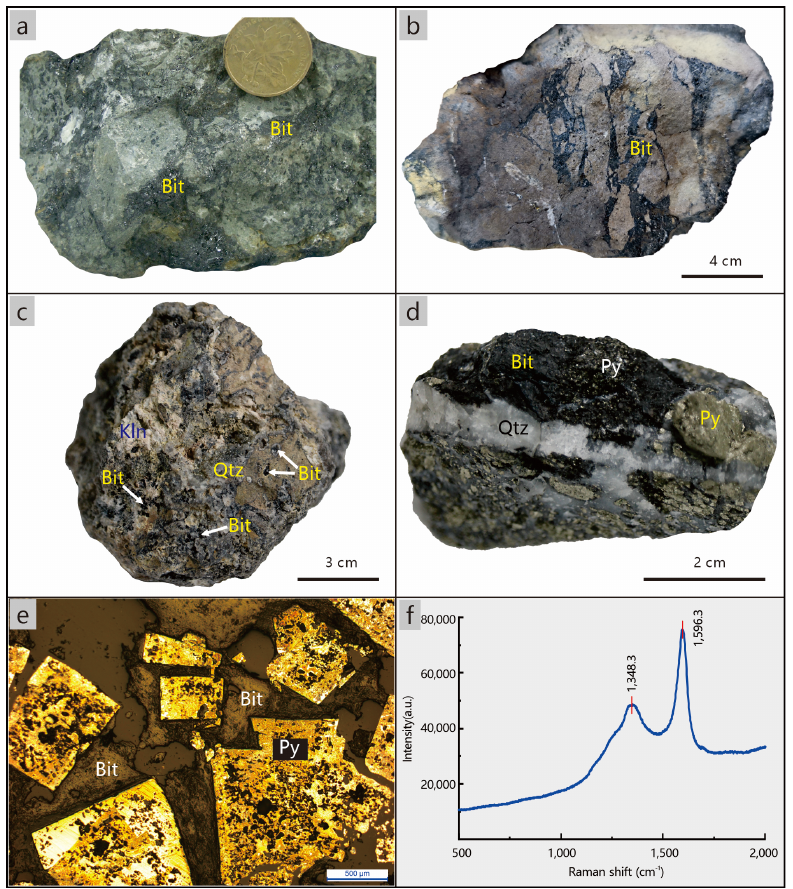
Figure 7. Characteristics of solid bitumen in surrounding rock from Qinglong antimony ore field. ( a ) Granular bitumen occurs in the pores of unaltered basalt in “Dachang layer”; ( b – f ) Bitumen in altered basalt of “Dachang layer”; ( b ) thin film bitumen distributed along basalt fissures; ( c ) granular bitumen is paragenetic with quartz and kaolinite; ( d ) lump bitumen is paragenetic with quartz and pyrite; ( e ) bitumen contains cubic pyrite particles; ( f ) laser Raman spectroscopy characteristics of bitumen. Abbreviations: Bit = Bitumen; Py = Pyrite; Kln = kaolinite.